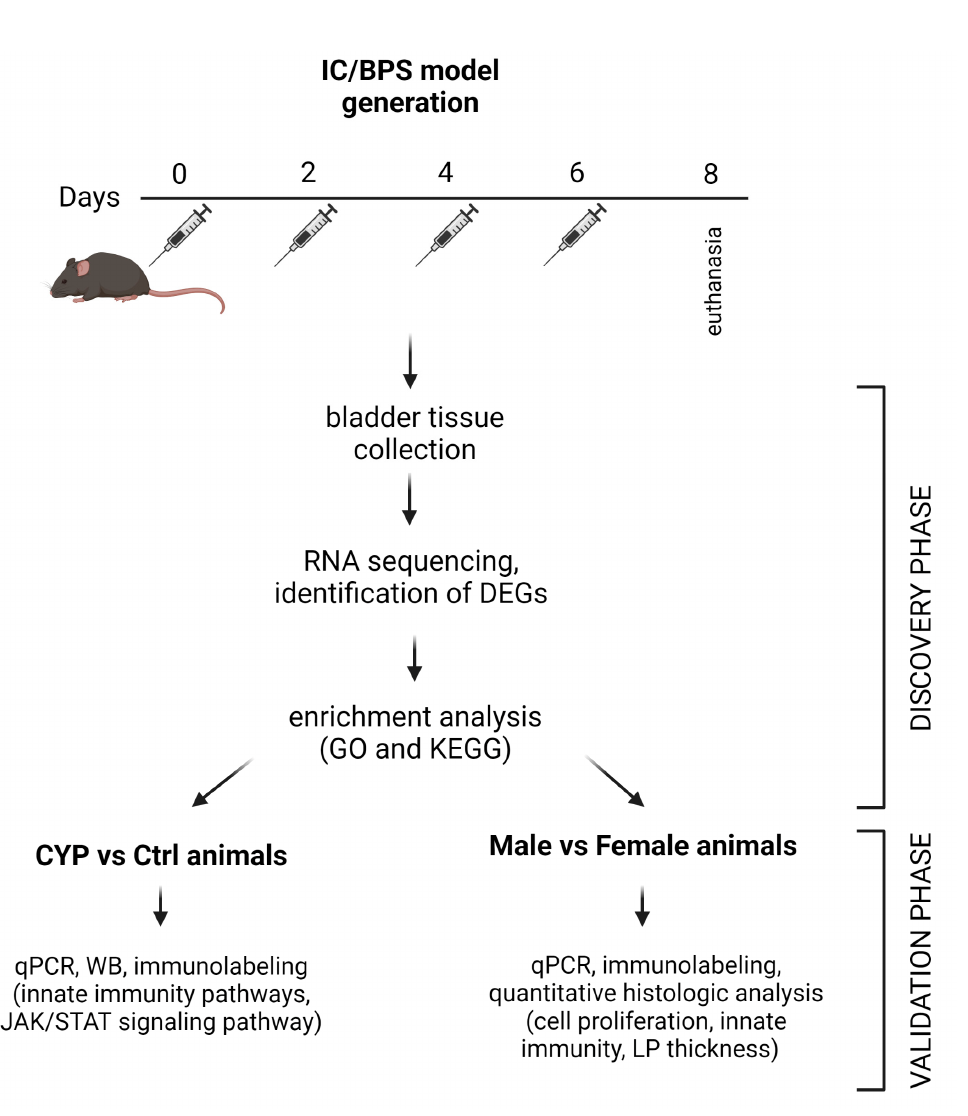
Figure 1. Representation of study workflow. Created with Biorender (accessed on 20 January 2023).